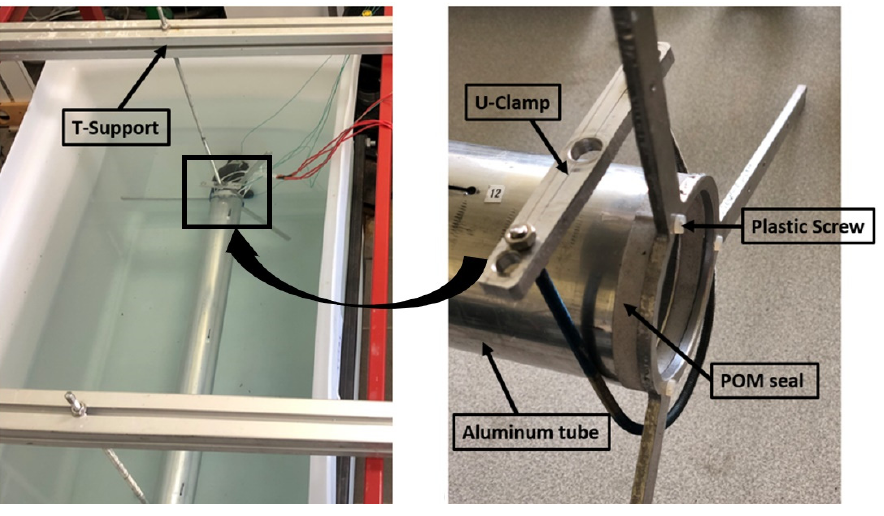
Figure 4. Experimental tube support.